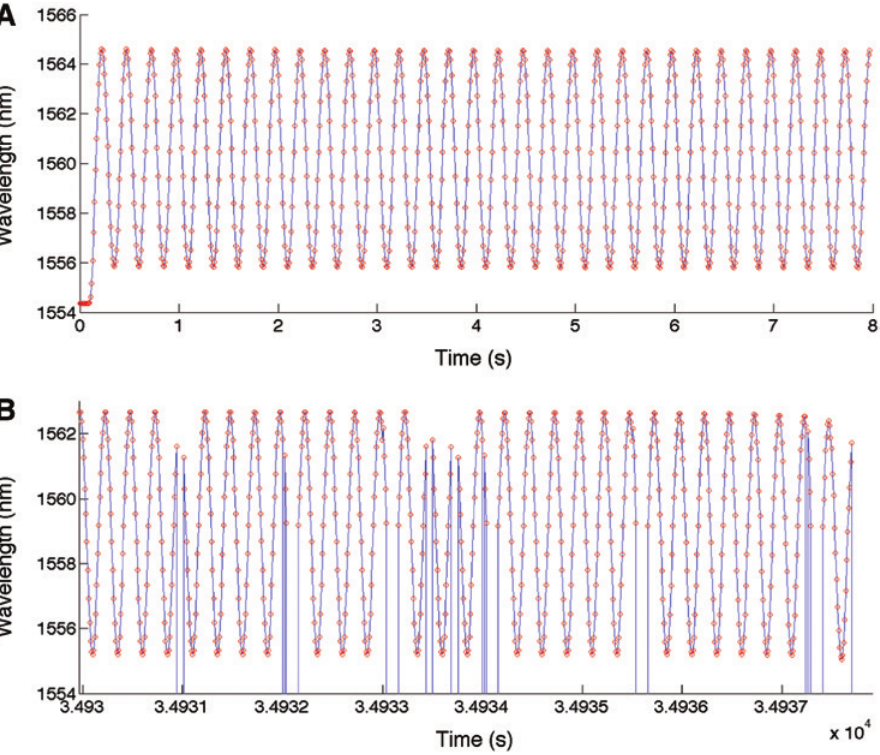
Figure 4: Cyclic variation of wavelength of 10-mm-long FBG: (A) initial 8 s and (B) final 8